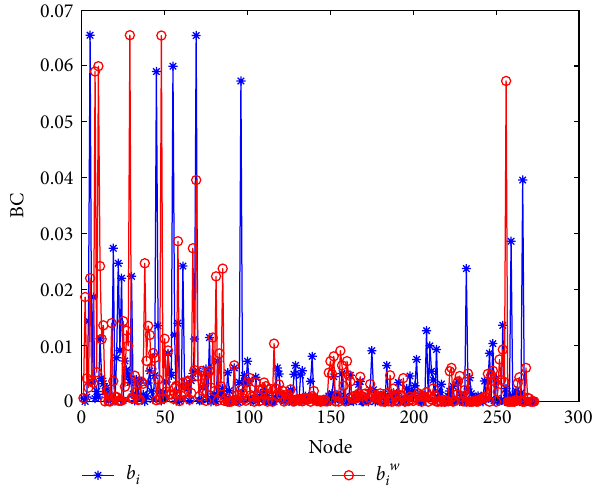
Figure 8: Distributions of BC 𝑏